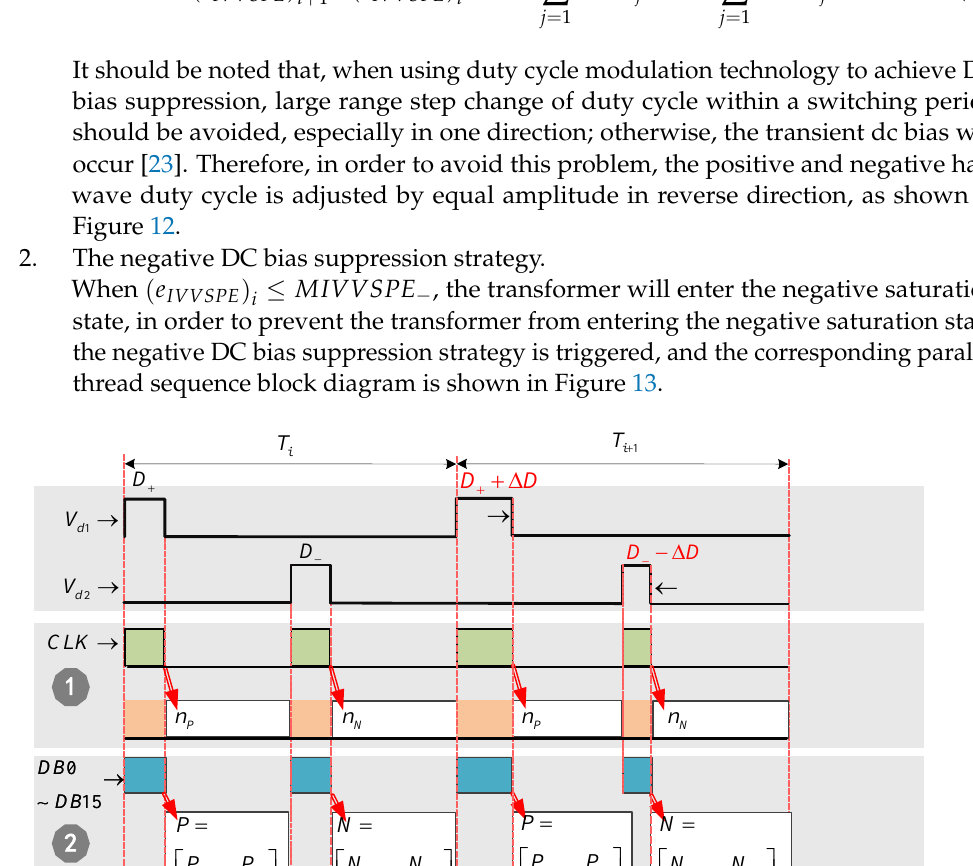
) quickly, and prevent IVVSPE i